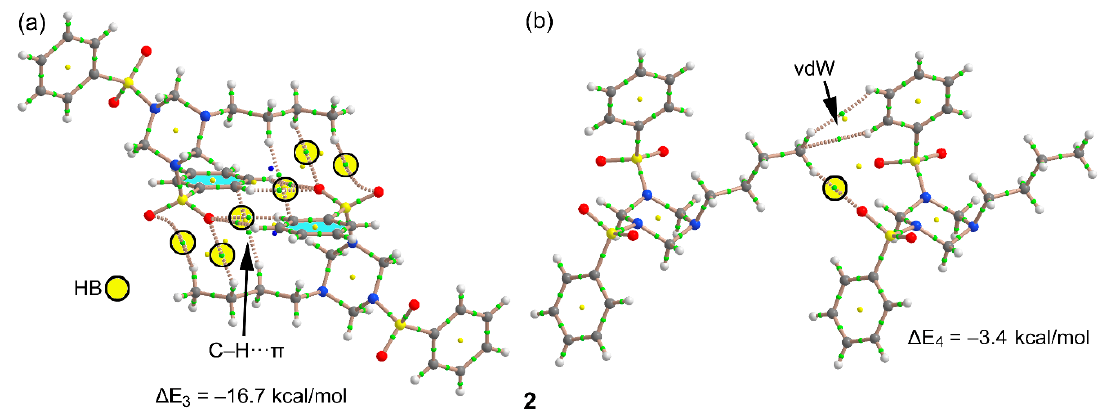
Figure 10. ( a , b ) Distribution of bond, ring and cage critical points (green, yellow and blue spheres, respectively) and bond paths in two dimers of complex 2 . The C–H ··· O bonds are highlighted.